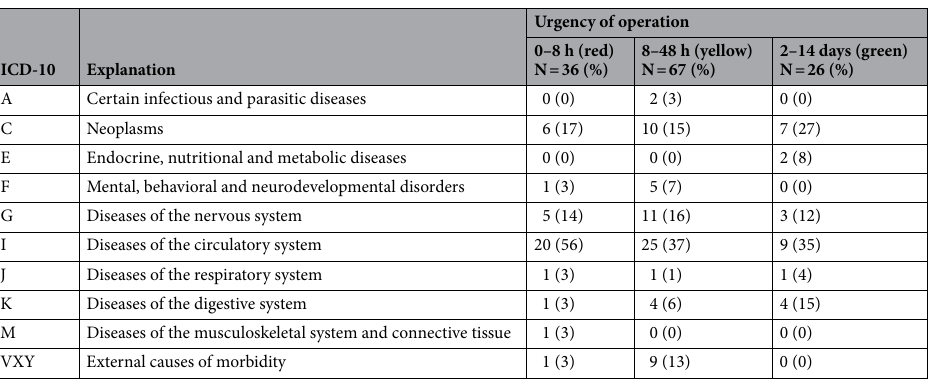
Table 4. Causes of death during the follow-up